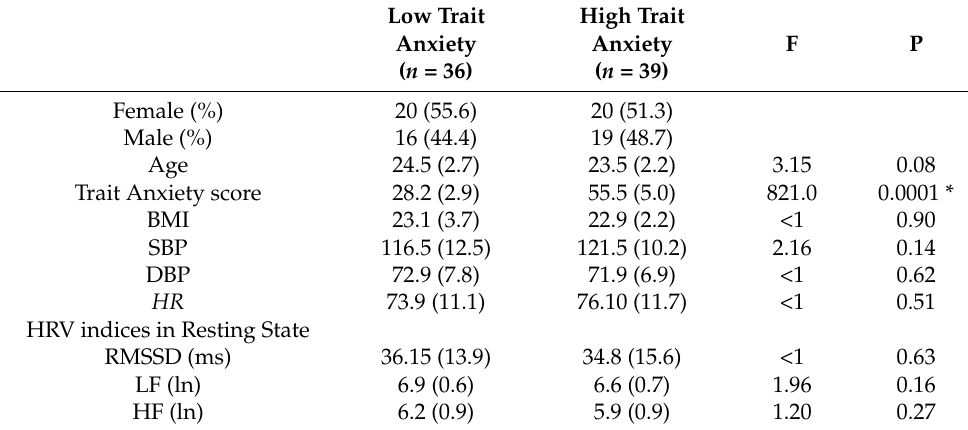
Table 1. Principal characteristics of the